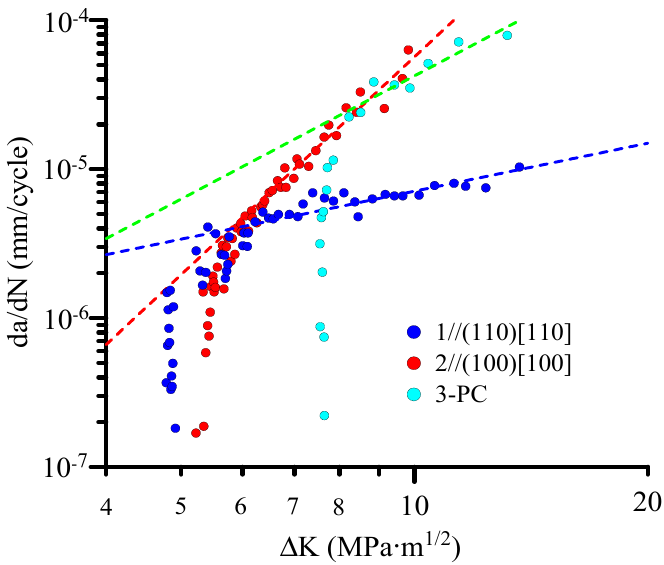
Figure 4. FCRG in monocrystals with the fastest-growing crack among the polycrystalline nickel specimens marked by black markers and lines. One crystal with a crack parallel to the (110) plane is designated 1, one crystal with a crack parallel to the (100) plane is designated 2, and the third one is the PC.